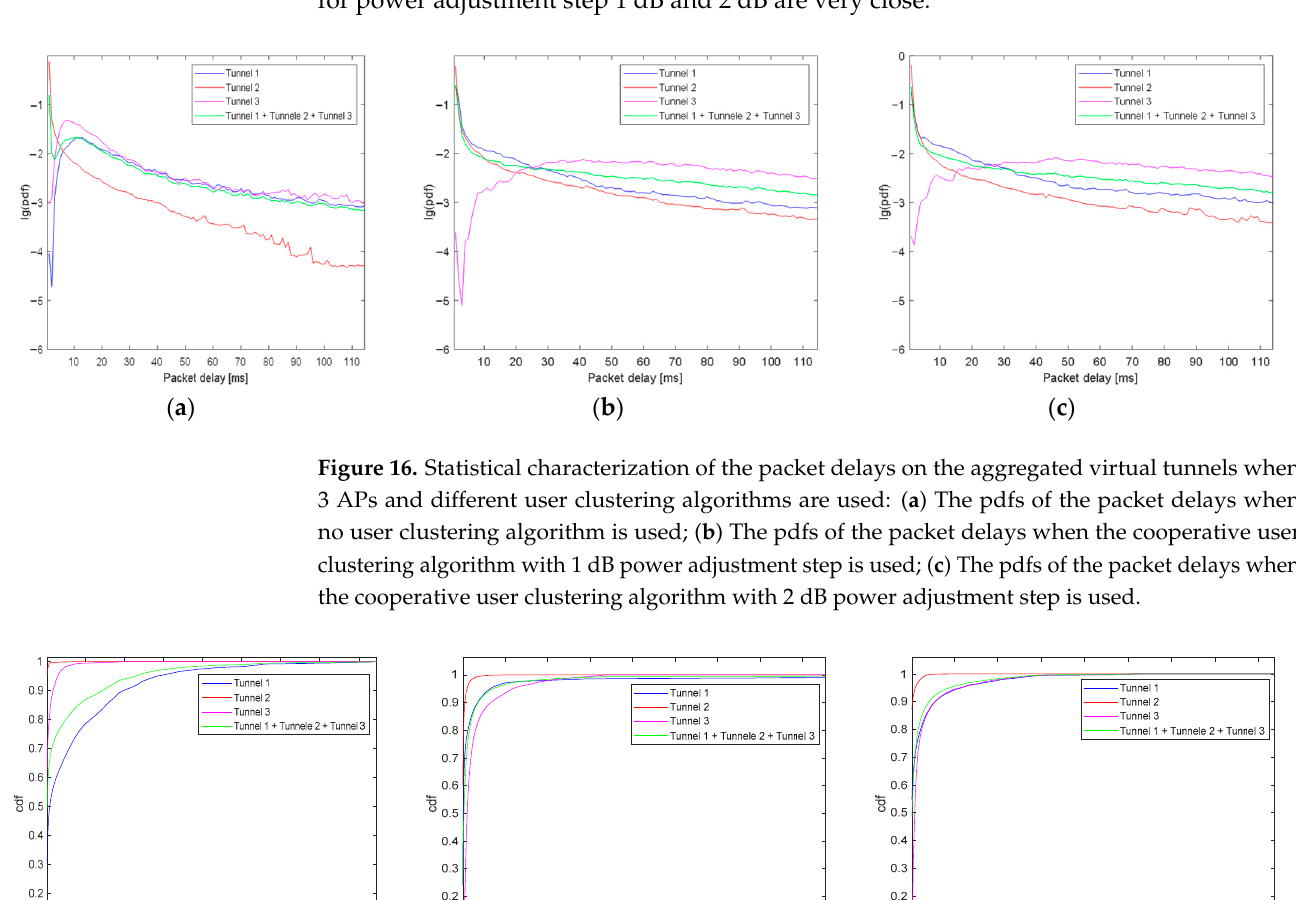
( c ) Figure 15. The Cumulative Density Functions of the packet delays on the aggregated virtual tunnels when 2 APs and different user clustering algorithms are used: ( a ) The cdfs of the packet delays when no user clustering algorithm is used; ( b ) The cdfs of the packet delays when the non-cooperative user clustering algorithm is used; ( c ) The cdfs of the packet delays when the cooperative user clus- tering algorithm is used. The results presented in Figure 15 show clearly the huge difference in performance, in what concerns the packet delays, of the systems with no users clustering (Figure 15a) and with user clustering (Figure 15b,c). Comparing Figure 15b,c we can see the difference between the non-cooperative and the cooperative clustering algorithms. In Figure 15c the curves converge around 500 ms while in Figure 15b the curves converge around 1500 ms. Still, should be noticed that the differences in the performance depicted in Figure 15b,c, i.e., the distribution of the packet’s delays, are small. Figure 16 presents the pdf of the packet delays in the system (the sojourn time) in the